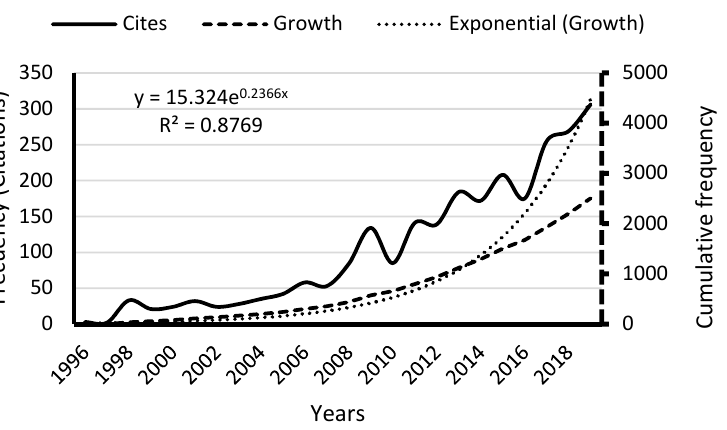
Figure 4. Annual evolution (growth) of the number of citations received SJFA.